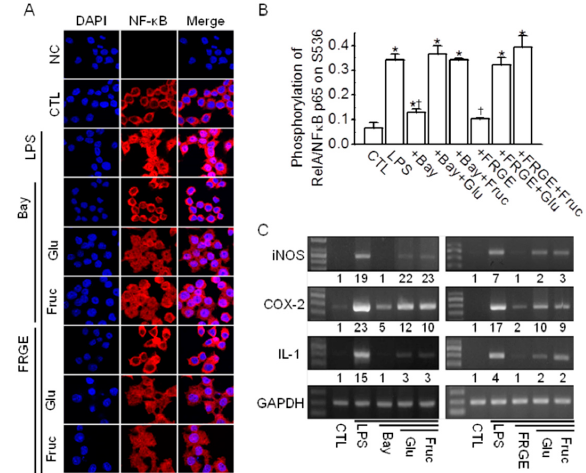
Figure 4. Sugars block the anti-inflammatory effect of FRGE in LPS-stimulated RAW264.7 cells through NF- κ B activation. ( A ) Nuclear translocation of NF- κ B upon treatment with FRGE and either glucose or fructose. RAW264.7 cells were pretreated with Bay 11-7085, FRGE, and/or glucose or fructose for 12 h and then exposed to LPS for 1 h. Fluorescent cells are labeled with the NF- κ B-specific antibody and Cy3-conjugated anti-rabbit IgG. The nucleus was stained with DAPI. The primary antibody was omitted in the negative control (NC). No red fluorescence was observed in the NC; only the DAPI stain was observed (blue color). The scale bar represents 50 μ m; ( B ) FRGE-induced NF- κ B suppression was decreased by co-treatment with glucose or sucrose in LPS-stimulated RAW264.7 cells. Total and phosphorylated NF- κ B p65 levels were analyzed by ELISA using total cell lysate. Each bar represents the mean ± SD of three independent experiments. The plus (+) sign represents conditions with treatment. * p < 0.05 compared with the control (CTL). † p < 0.05 compared with the LPS treatment; ( C ) FRGE-induce reduction in the expression of iNOS, COX, and IL-1 mRNA was decreased by treatment with glucose or fructose in LPS-activated RAW264.7 cells. Total cell lysates were obtained using lysis buffer and subjected to RT-PCR. First-strand cDNAs were synthesized from 1 μ g of total RNA isolated from the RAW264.7 cells, and the same concentration was used as the template for PCR. GAPDH was used as a loading control for the mRNA expression levels. The numbers below the PCR band represent the normalized ratio of the expression levels of iNOS, COX-2, and IL-1 to those of GAPDH for each lane. Bay, Bay 11-7085; Glu, glucose; Fruc, fructose.